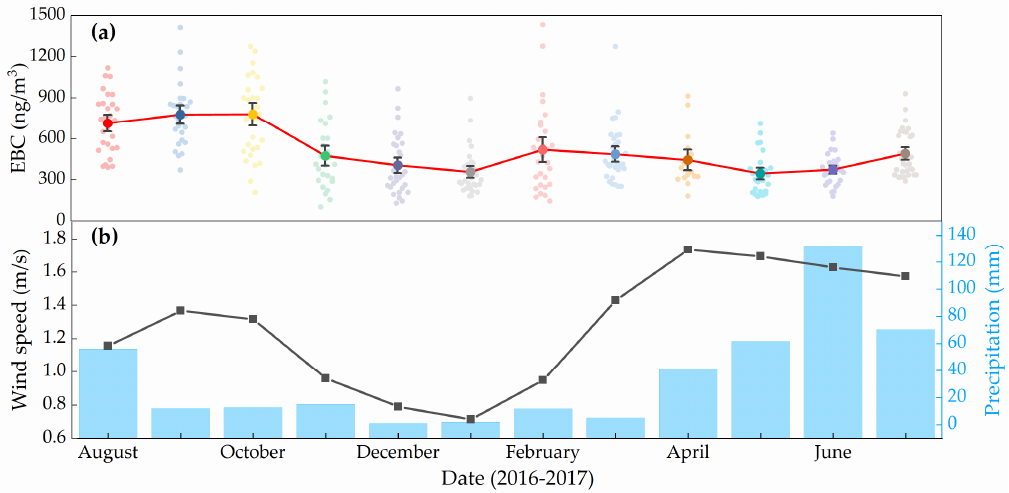
Figure 3. The monthly mean ( a ) EBC concentrations, ( b )wind speed and precipitation observed at